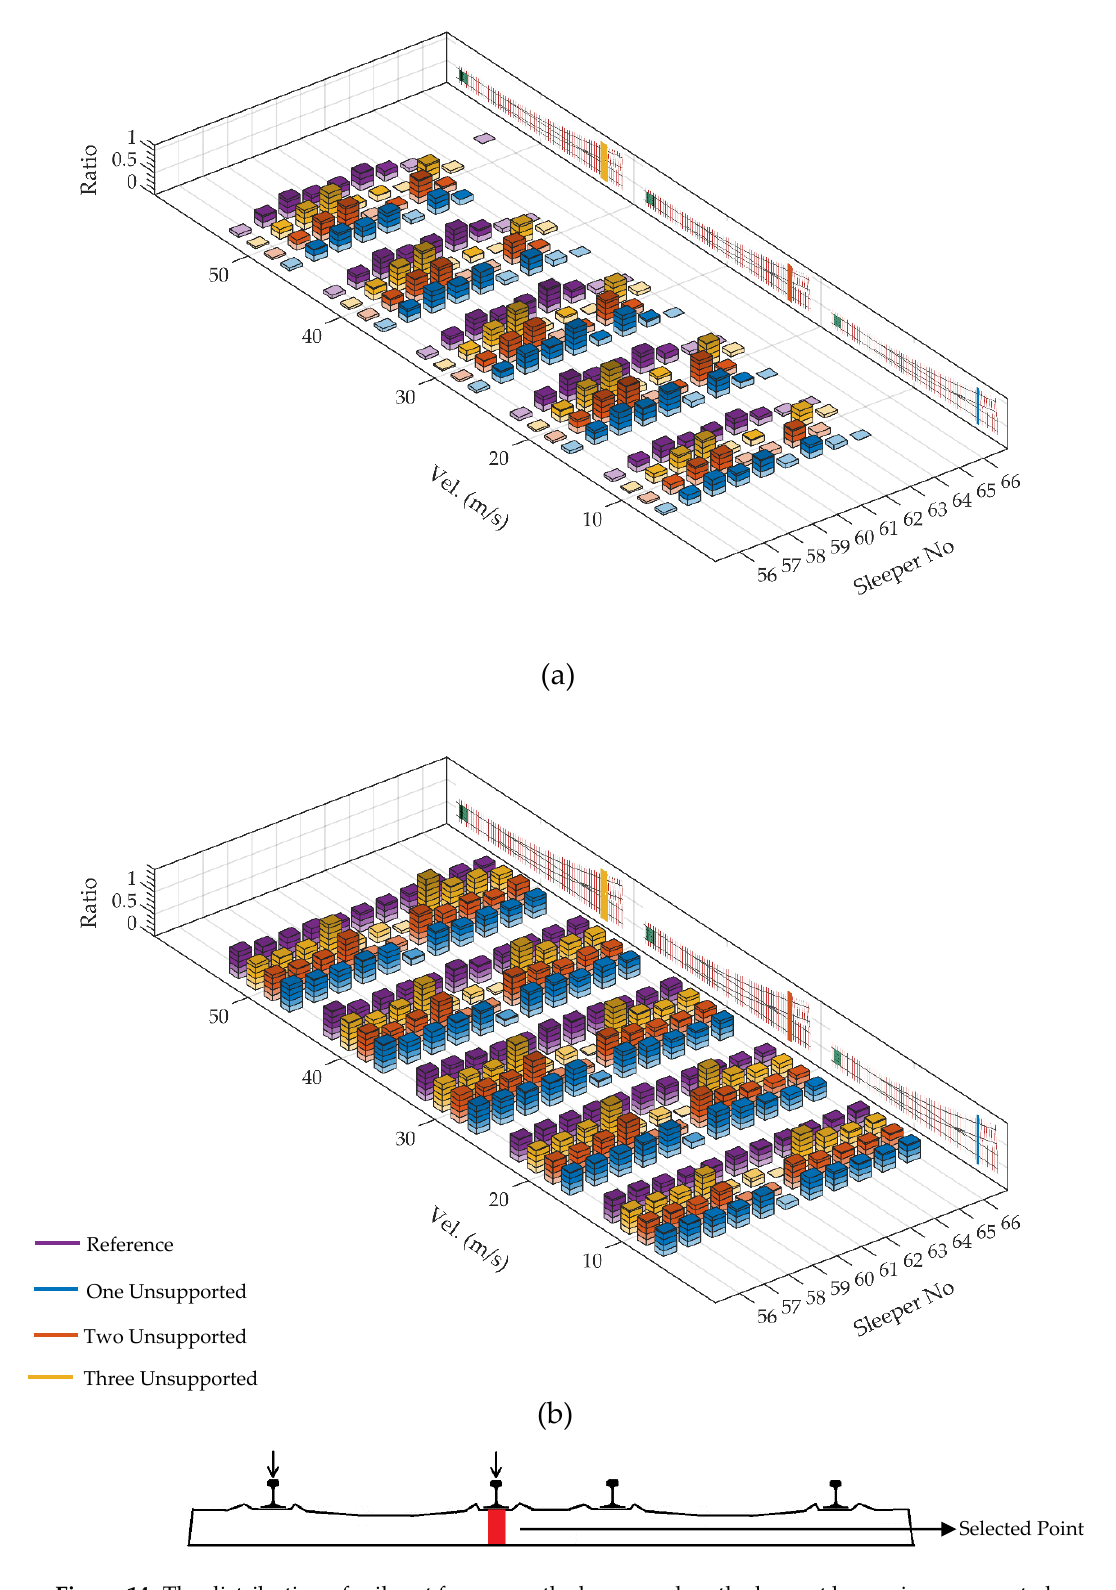
Figure 14. The distribution of rail seat force over the bearers when the longest bearer is unsupported: ( a ) at particular time when the front wheel is on the bearer with number 61; ( b ) when maximum occurs at each bearer.